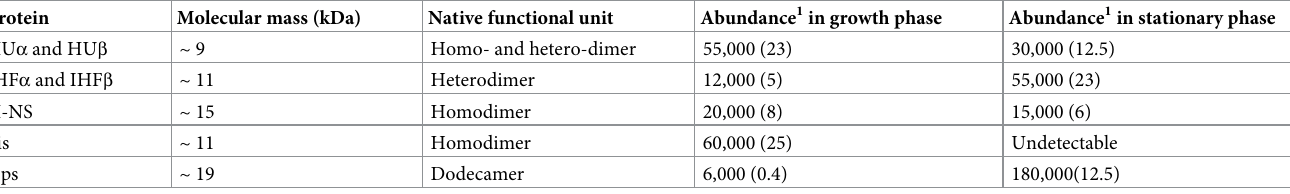
Table 1. Properties and the abundance of major nucleoid-associated proteins of E . coli .